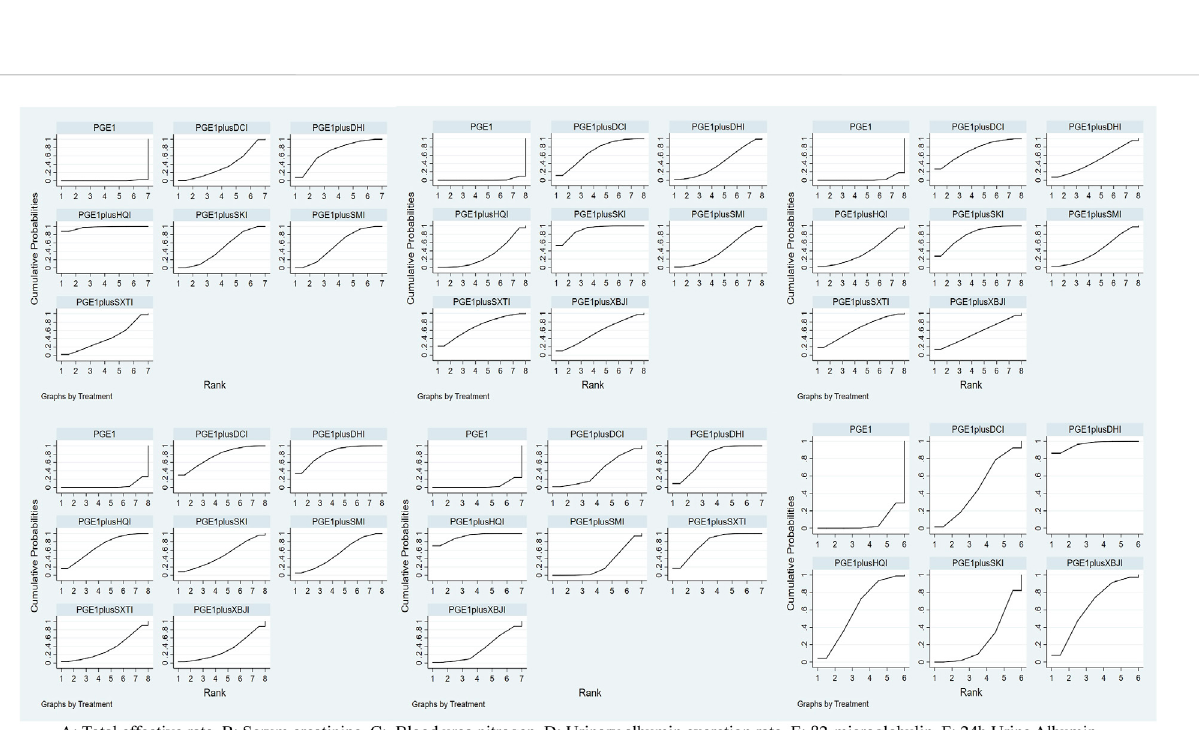
Xuebijing injection; PGE1, alprostadil injection.